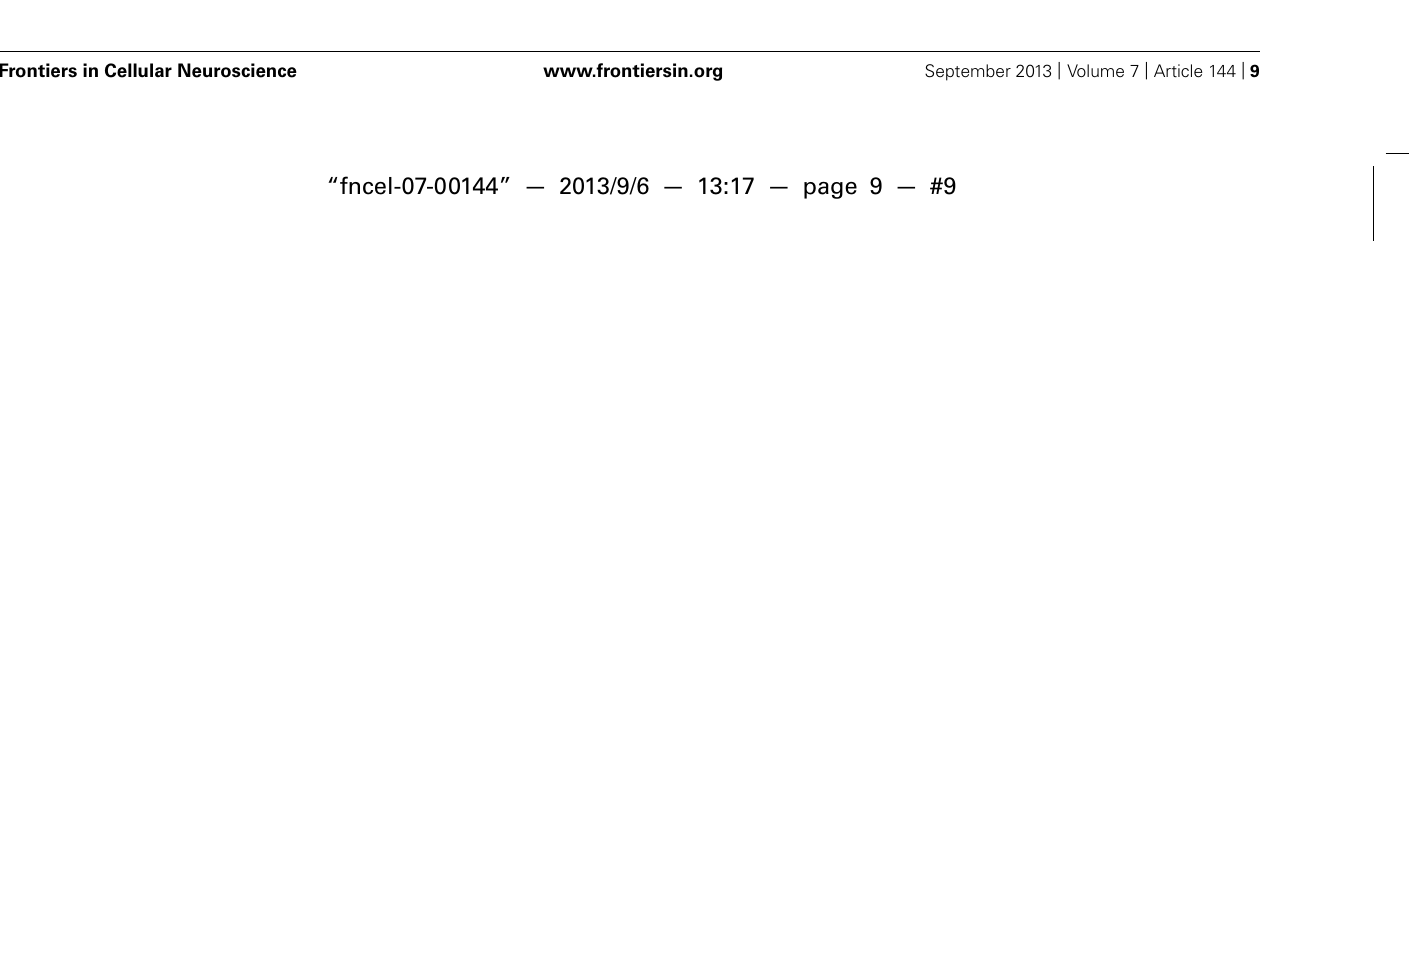
pro-inflammatory cues. However, extreme caution should be exercised since these same PUFAs may not provide complete safety to halt degeneration induced by parkinsonian toxins or even trigger adverse effects, which eventually aggravates the extent of the pathological